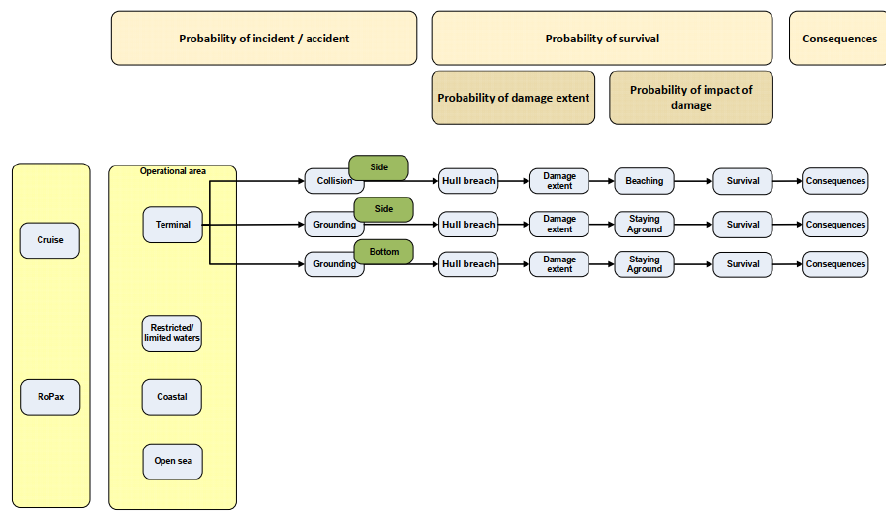
Figure 10. High-level structure of an influence model guiding the development of high level flooding risk models. Figures 11 and 12 show the different levels or filters used for the collision and ground- ing high level risk models employed in project FLARE.